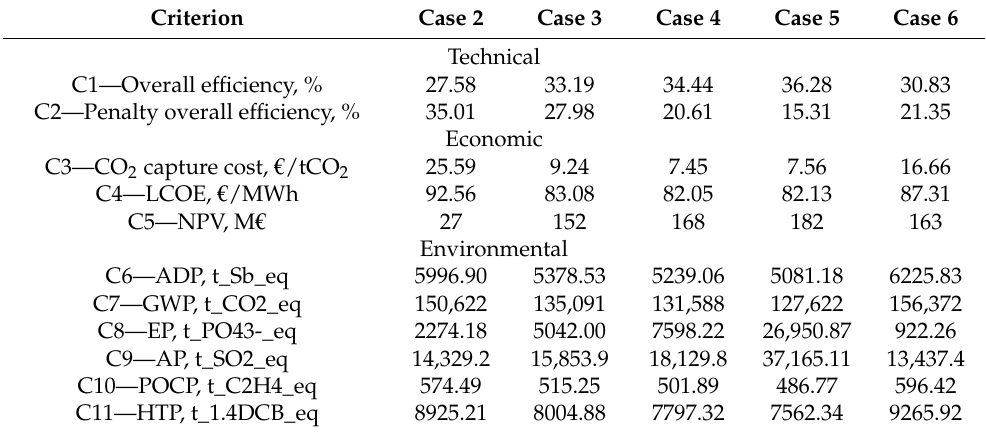
Table 8. Multi-criteria analysis input data.